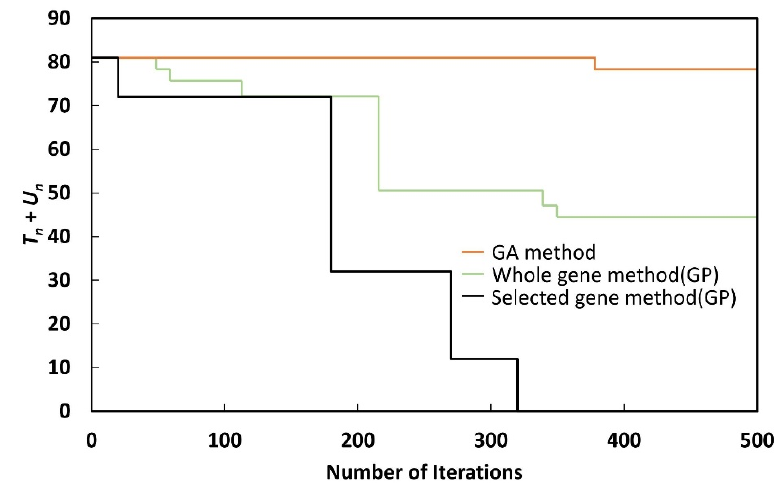
Figure 15. GP results for the minimized fitness function (2024).